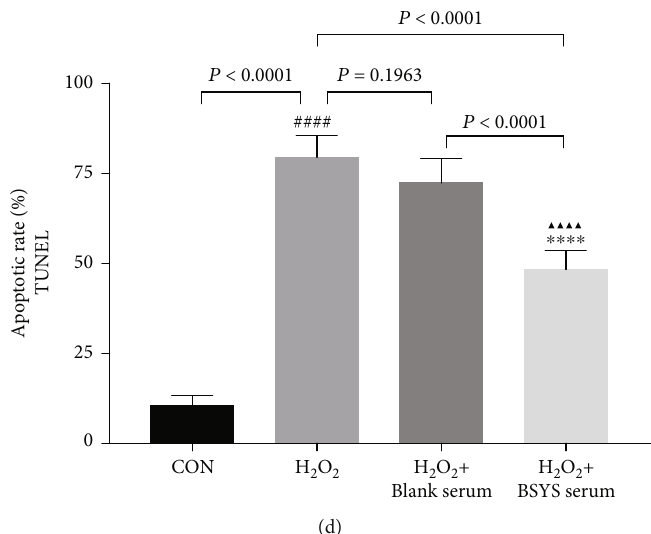
Figure 8: BSYS serum suppresses H O -induced apoptosis of OLN-93 cells. (a, b) Apoptotic nuclei of OLN-93 cells were stained by Hoechst 2 2 33342. Scale bar = 25 μ m . (c, d) The apoptotic cells (red fl uorescence) were detected by TUNEL, and the nuclei (blue fl uorescence) were stained by DAPI. Scale bar = 25 μ m . Data are presented as means ± SD , compared with the CON group, #### P < 0 : 0001 ; compared with O group, ∗∗∗∗ P < 0 : 0001 , and compared with the H O +blank serum group, ▲▲▲▲ P < 0 : 0001 the H 2 2 2 2